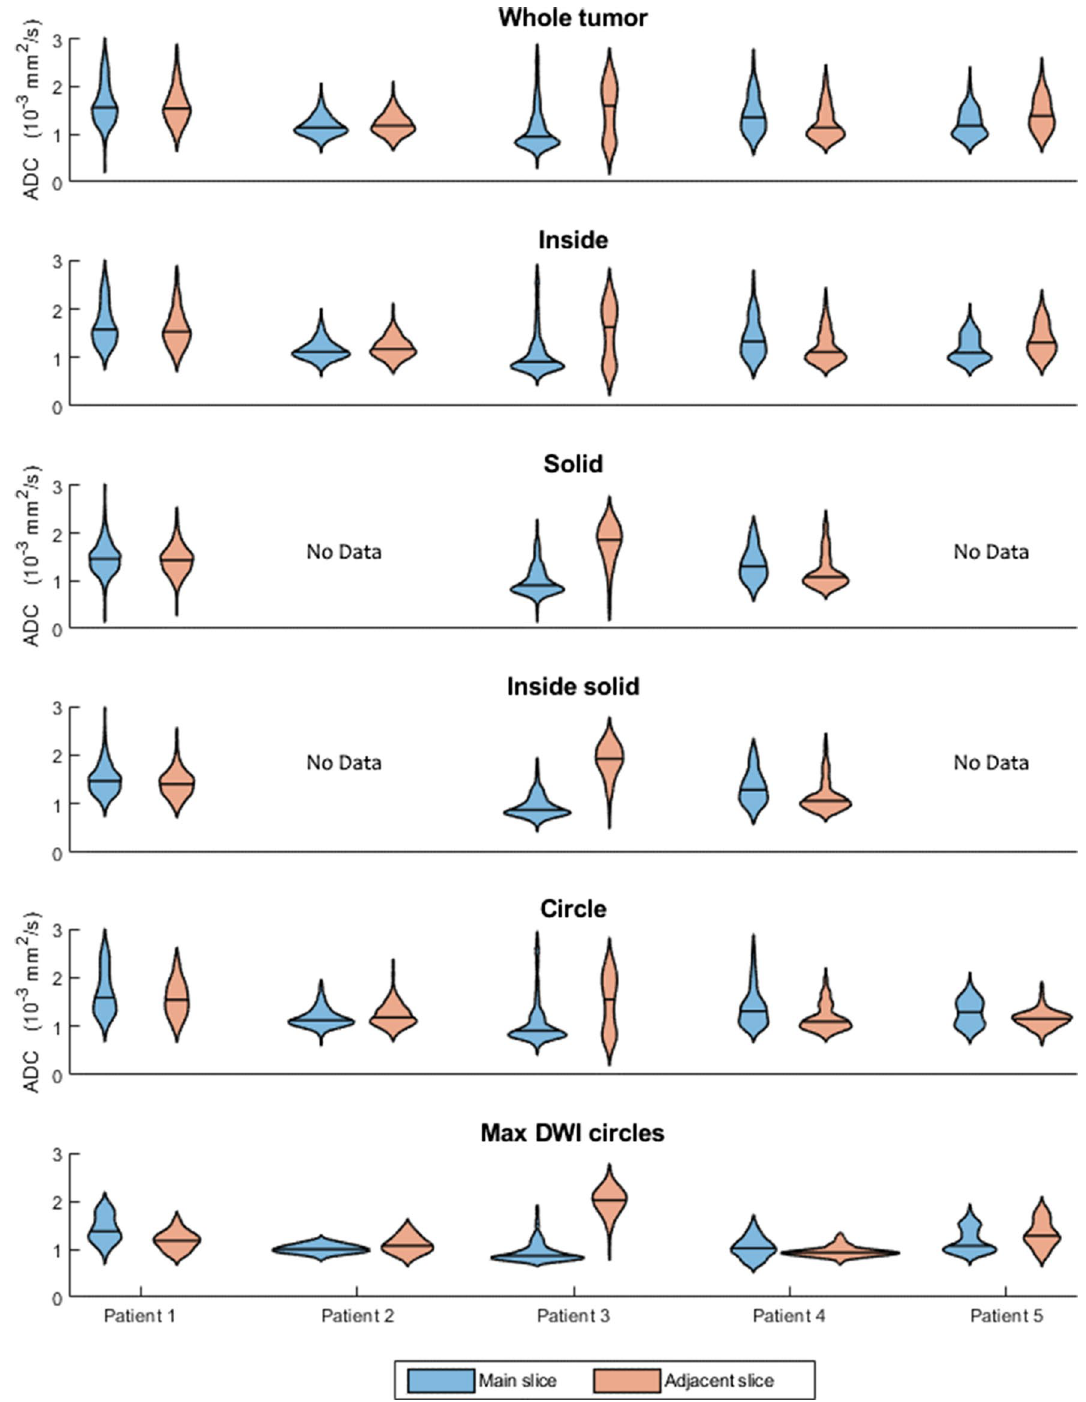
Fig. 5 Violin plots of the apparent diffusion coefficient (ADC) estimated on two slices spaced two slices apart from each other. The estimations were derived from five patients with the regions of interest (ROIs) as defined by the six different segmentation strategies. Patients 2 and 5 did not show any necrotic, cystic, or hemorrhagic tumor components and as such, specific ROI that excludes these have not been